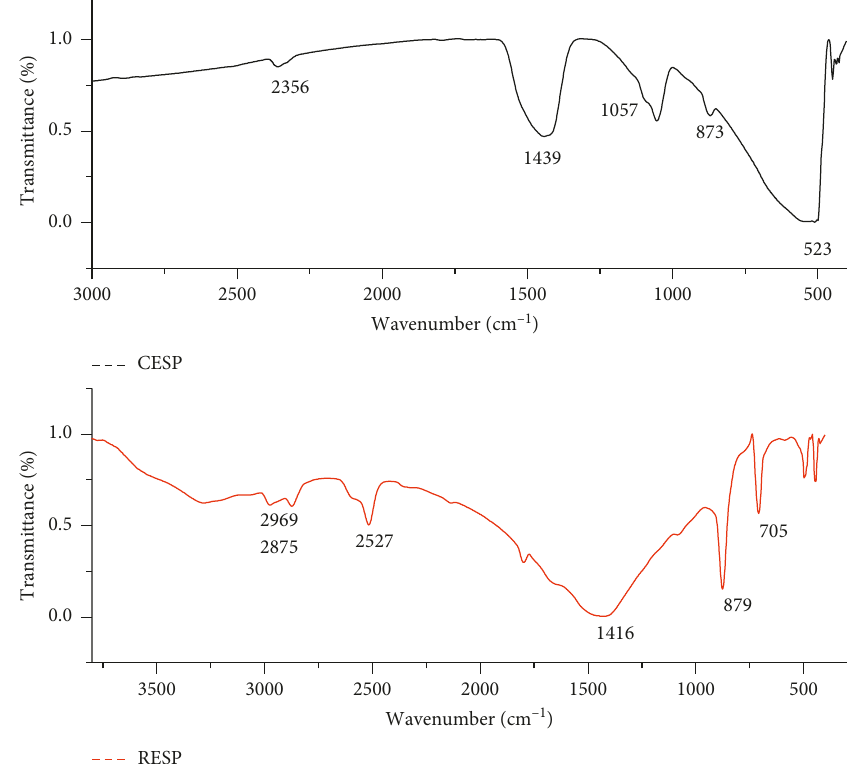
Figure 2: FTIR spectra of raw egg shell powder and calcined egg shell powder.